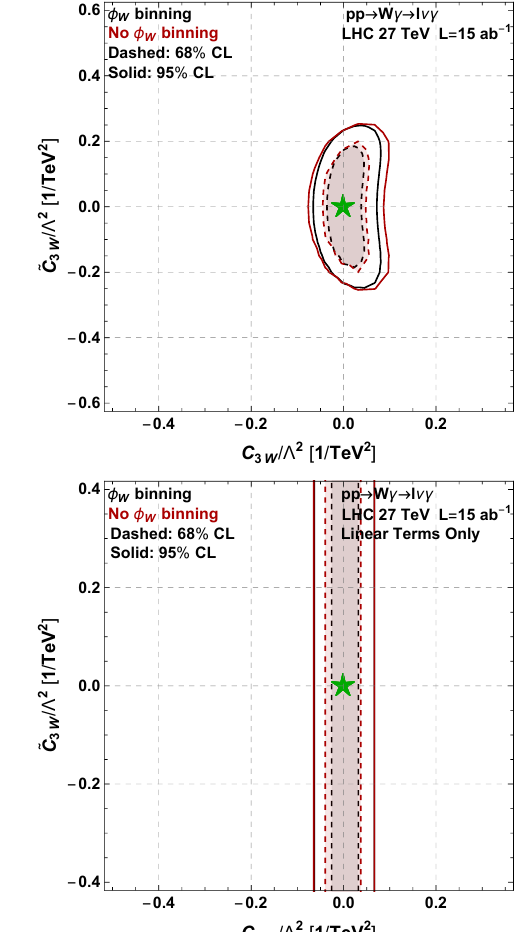
Figure 11 . 95% bound on the c 3 W and ~ c 3 W Wilson coe(cid:14)cients computed with two equally spaced angular (cid:30) W bins in function of the largest W(cid:13) system transverse mass bin used for the 27 TeV LHC with 3 ab (cid:0) 1 (solid) and 15 ab (cid:0) 1 (dashed) of integrated luminosity. A systematic error of 5% has been assumed.